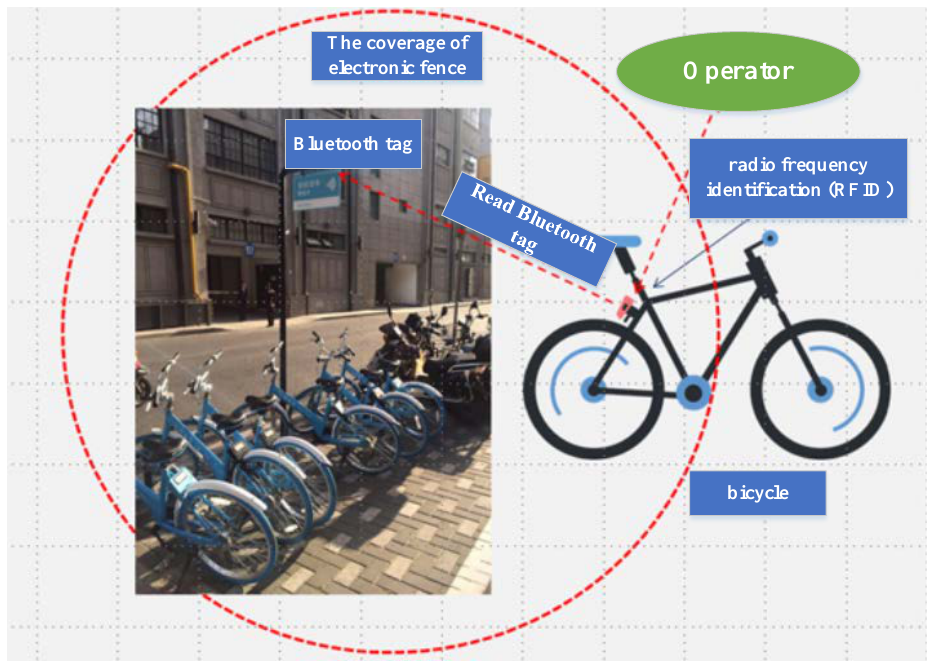
Figure 1. A typical electric fence.